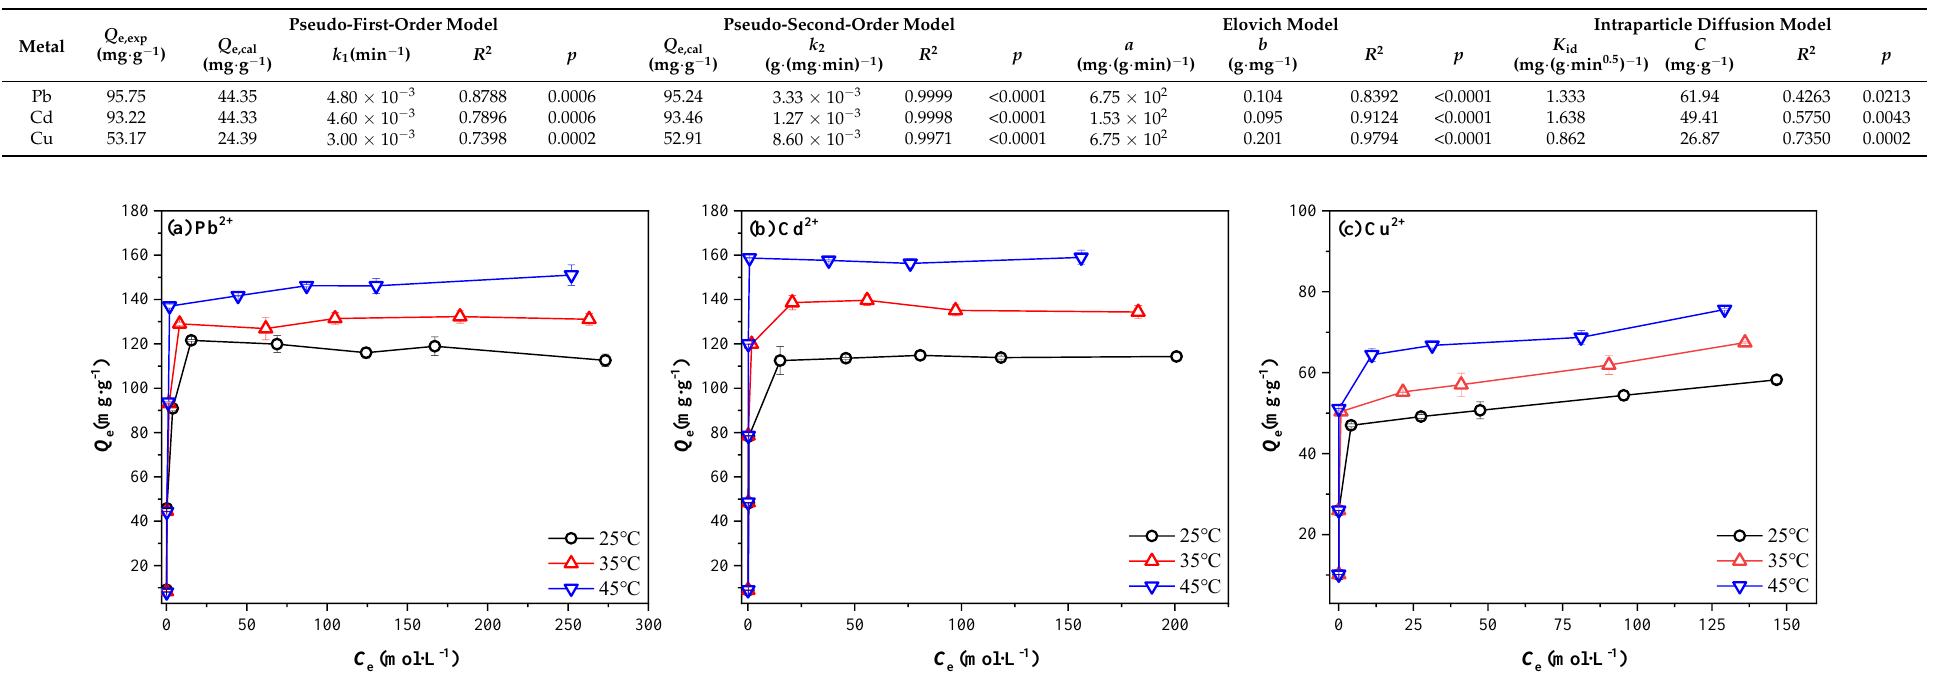
Table 2. Adsorption kinetics parameters for various adsorption kinetics models.